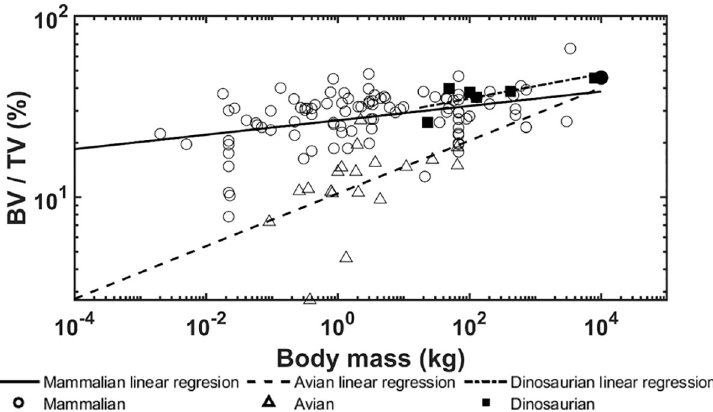
Fig 6. Logarithmically scaled plots of the bone volume fraction (BV/TV) versus body mass. Pairwise comparisons indicate the dinosaur regression slope is not different from the mammalian (p = 0.352) and avian (p = 0.695) slopes. The solid circle indicates the mammoth.